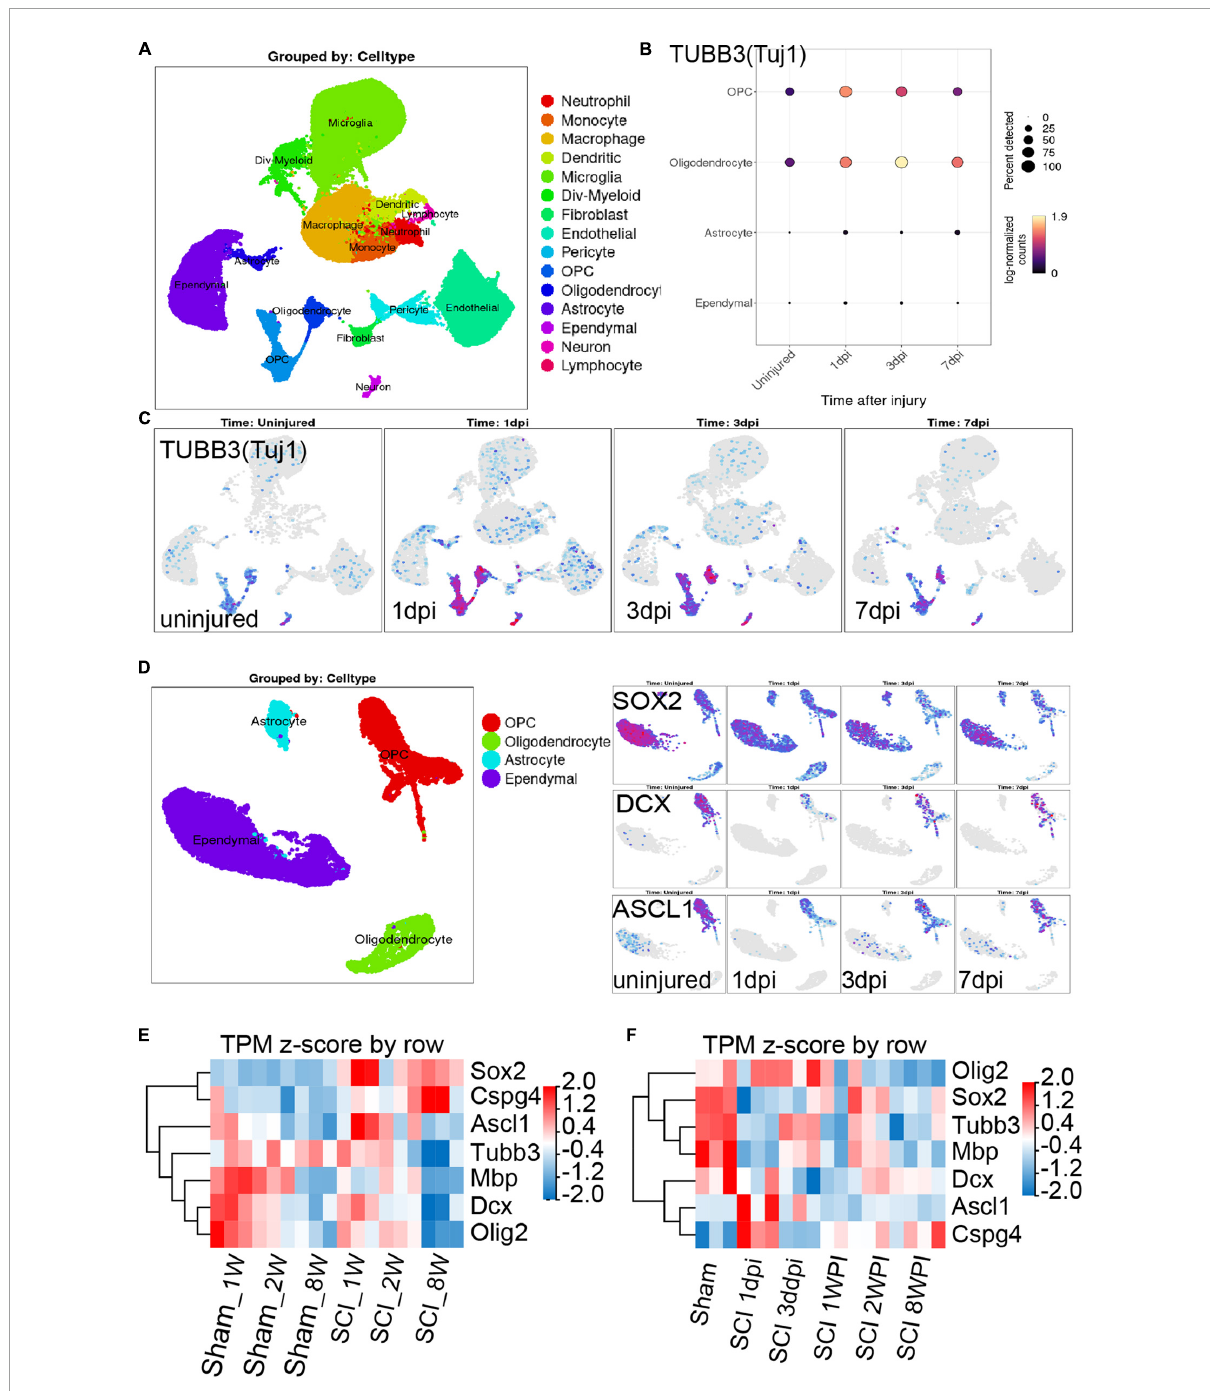
FIGURE5 Combining the scRNA-seq and RNA-seq data to investigate the neurogenesis potential of oligodendrocyte progenitor cells (OPCs) after spinal cord injury (SCI). (A–C) scRNA-seq results show that oligodendrocyte lineage cell along with neurons were Tuj1-specific expressing cells under normal conditions and after SCI. dpi = day post-injury. (D) Sox2, DCX, and ASCL1 were highly or specifically expressed in OPCs under normal conditions, while these factors were significantly down-regulated after SCI. dpi = day post-injury. (E,F) RNA-seq results show the transcript changes of the above factors along with the marker of oligodendrocyte cell lines in the lesion area at different ages and time. dpi, day post-injury; WPI, week post-injury; 1 W, 1-week-old; 2 W, 2-week-old; 8 W, 8-week-old; sham_1 W, 1-week-old sham group; sham_2 W, 2-week-old sham group; sham_8 W, 8-week-old sham group; SCI_1 W, 1-week-old SCI group; SCI_2 W, 2-week-old SCI group; SCI_8 W, 8-week-old SCI